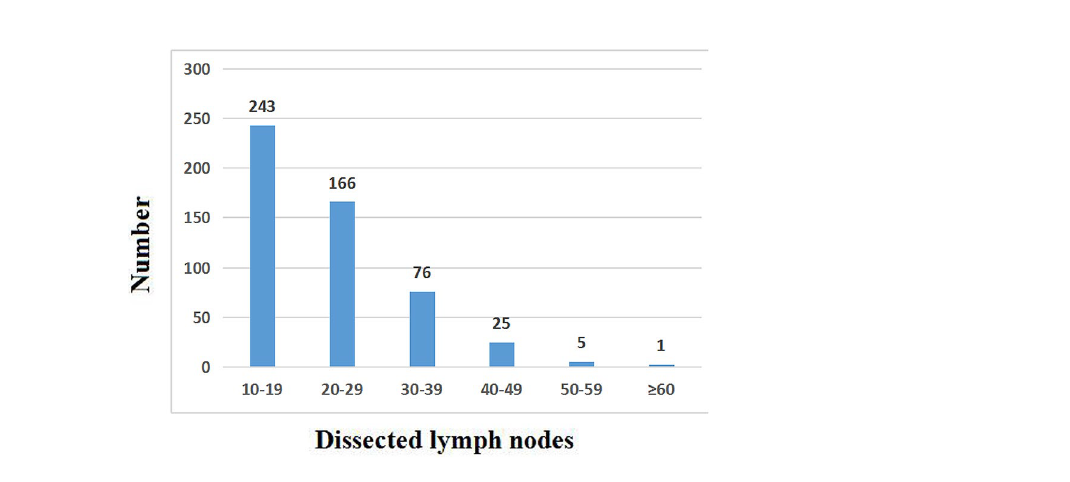
Figure 3. The distribution of the number of lymph